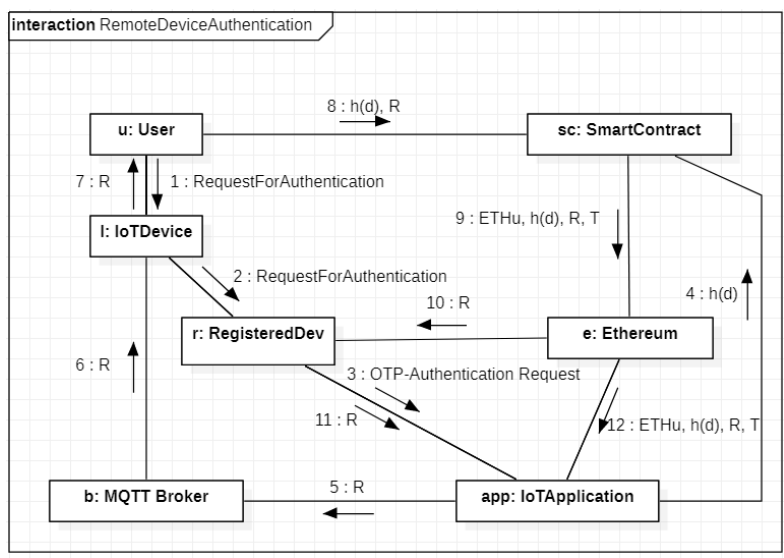
Figure 4. Authentication of a remote